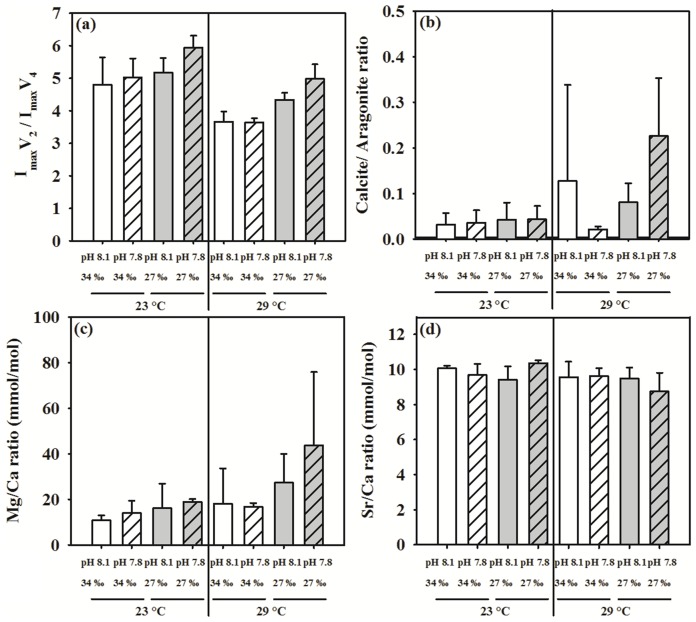
Effects of pH, salinity and temperature on the tube composition of Hydroides elegans, (a) the intensity ratio (Imax) of the two FT-IR absorption peaks at 855 cm−1 (ν
2) and 713 cm−1 (ν
4), Imax
ν
2/Imax
ν
4 ratio, is an indicator of amorphous CaCO3 content; (b) calcite/aragonite ratio, (c) Mg/Ca ratio, (d) Sr/Ca ratio.Each bar represents the mean ± SD of four replicates.